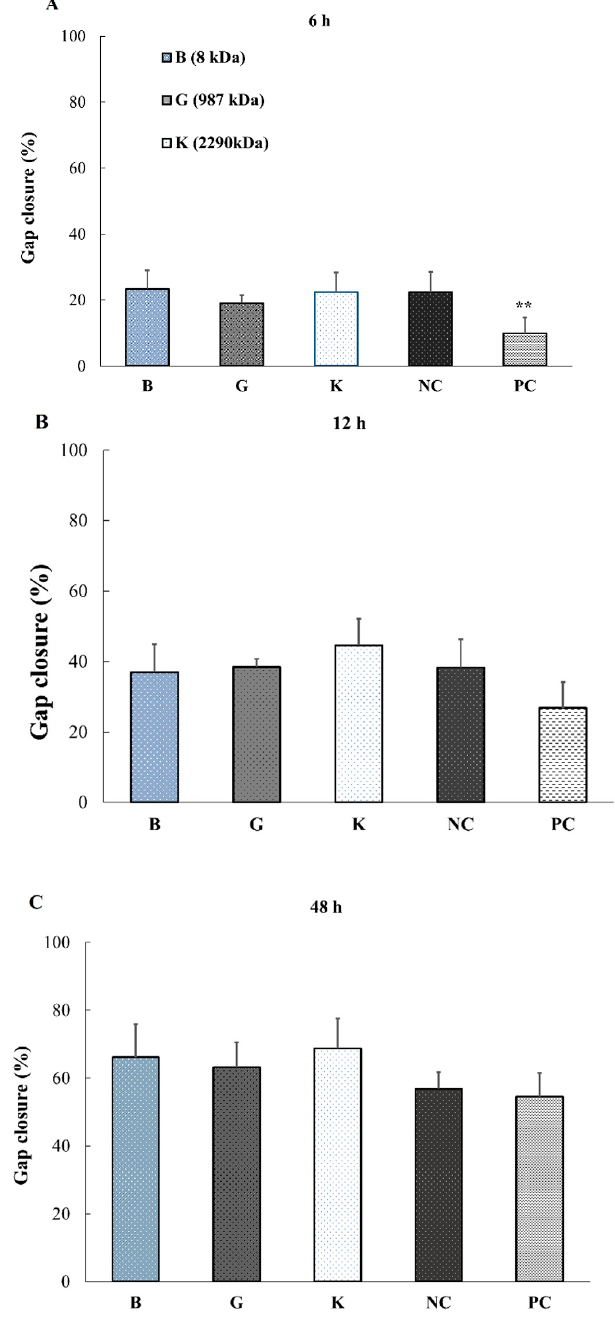
Figure 7. Fibroblast wound closure without MMC evaluated by wound scratch assay at different time points: 6 h ( A ), 12 h ( B ) and 48 h ( C ) using HA-B (8 kDa), -G (987 kDa) and -K (2290 kDa) (0.1% HA, n = 5, ** p < 0.01 vs NC group, Dunnet test).